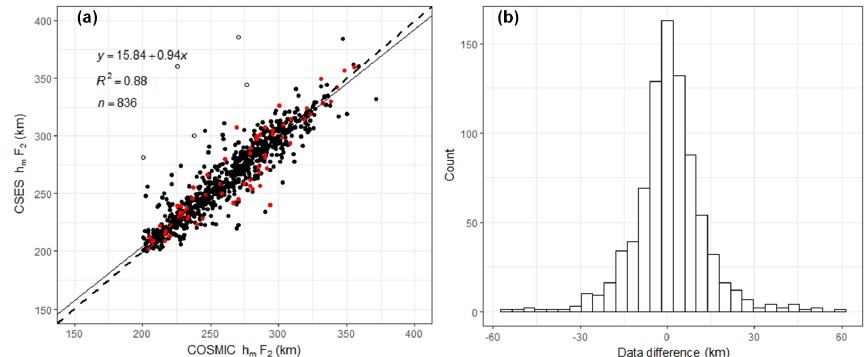
Figure 6. Scatter plot of hm F2s for CSES and COSMIC and histogram of their differences. The dashed line is the equal-value line with a slope of 1, and the solid line is the linear fitting line. The y axis refers to the CSES hm F2, and the x axis to COSMIC hm F2. Open circles are points exceeding 3 times the standard deviation of data differences between matched points. Red points are peak height obtained under geomagnetic conditions of Dst < − 30nT.